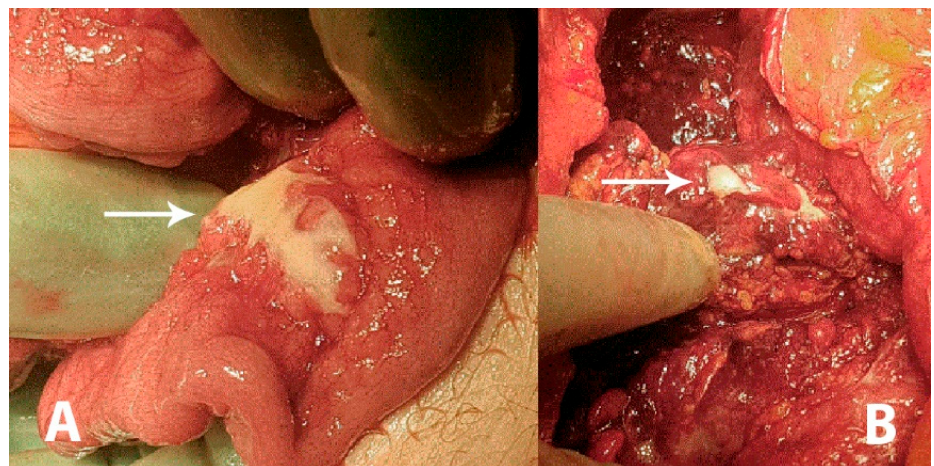
Figure 1. A 43-year-old previously healthy male was admitted to the surgical unit by his general practitioner with suspicions of acute diverticulitis. The patient complained of constant pain in the epigastric region and under the right and left rib curvature for the previous week upon admission. The pain was intensified when bending forwards and accompanied by an unspecific feeling of fatigue. The patient reported similar symptoms three weeks prior to admission, which remitted spontaneously. Any systemic symptoms of fever, unintended weight loss or night sweats were denied. At admission, the patient had a slight tachycardia; all other vital parameters were normal. Initial laboratory data came out with an elevated C-reactive protein (CRP; 176 mg/L) and a slightly elevated total leukocyte count (9.8 × 10 9 /L). Hepatic and renal biochemical markers were within normal ranges. On physical examination the abdomen was described as tender in the upper quadrants and around the umbilicus but without peritoneal reaction. On suspicion of an intraabdominal abscess, a computed tomography